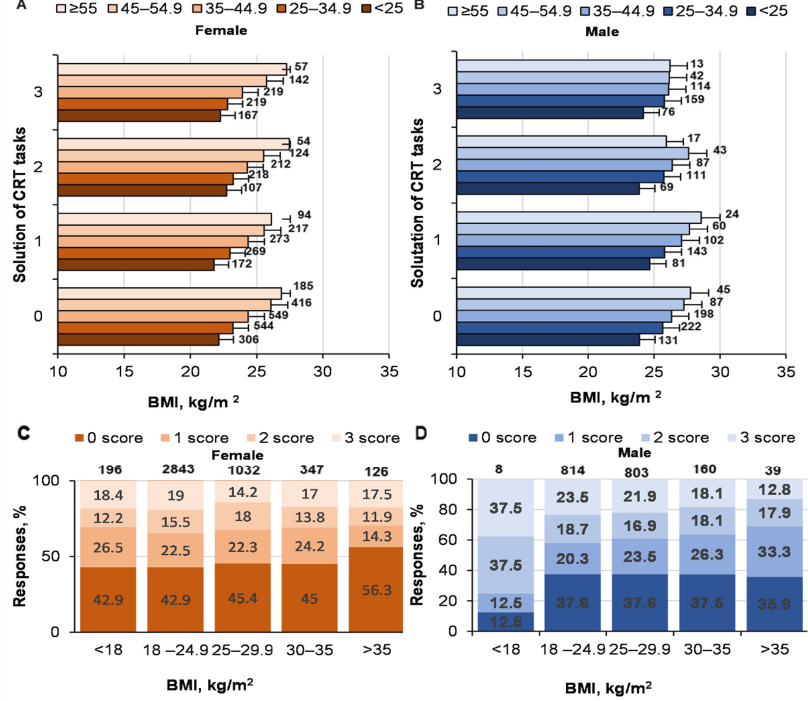
Figure 2 . Solving CRT tasks and BMI. At the top of the column is the number of participants. (( A )—women solutions of CRT and BMI; ( B )—men solutions of CRT and BMI; ( C )—women CRT responses % and BMI; ( D )—men CRT responses % and BMI).